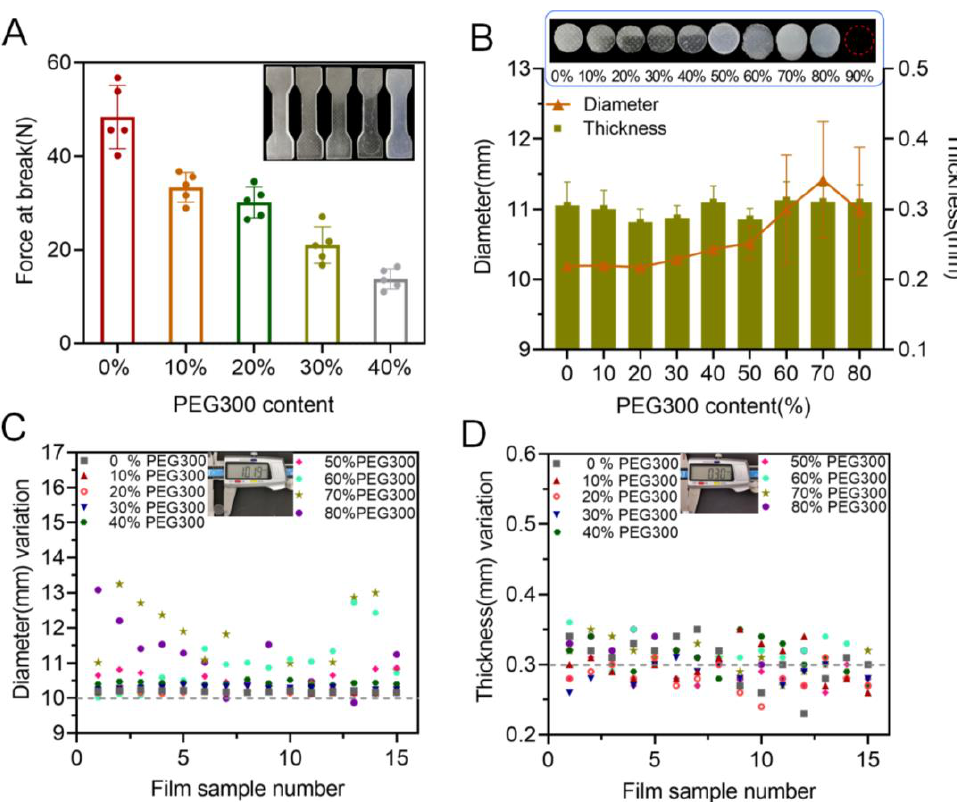
Figure 3. Effect of PEG concentration on printability: ( A ) effect of PEG content on the tensile strength (n = 6); ( B ) effect of PEG content on the diameter and thickness of the produced oral films (n = 15); ( C ) diameter variations of the 3D-printed oral films; ( D ) thickness variations of the 3D-printed oral films.